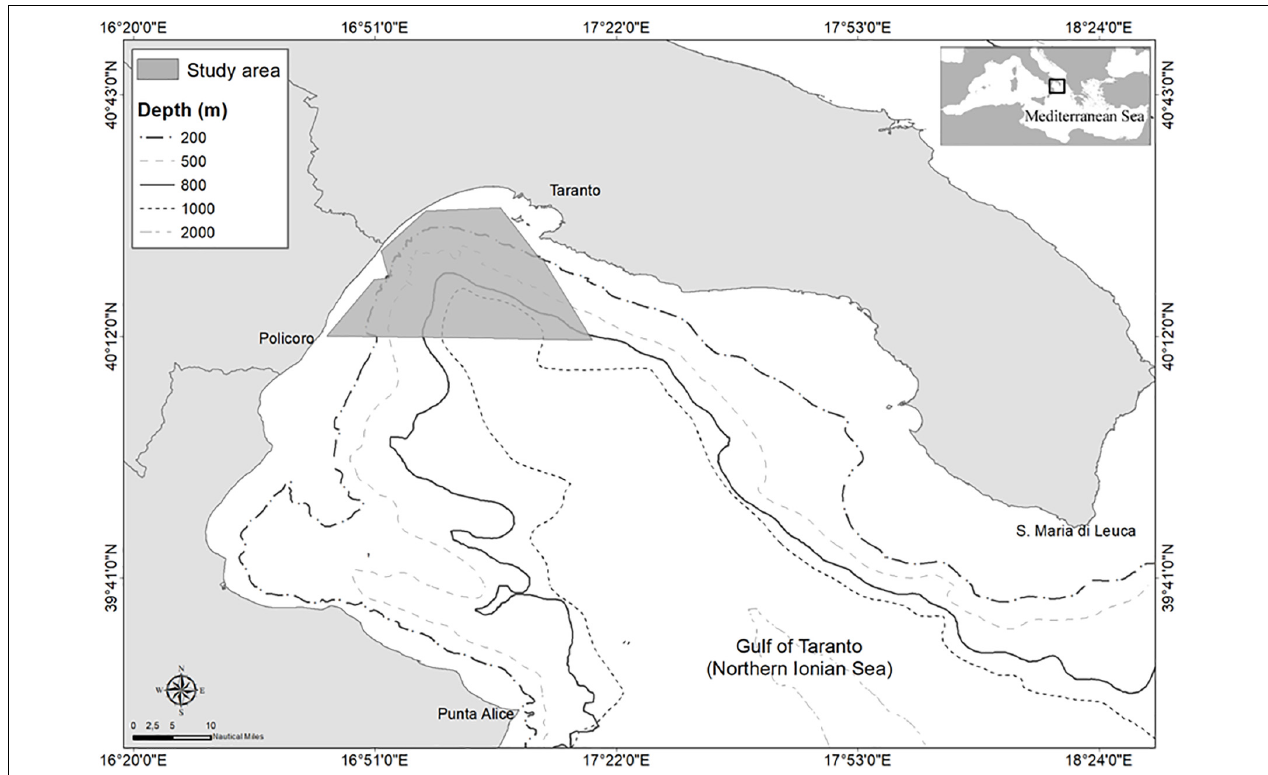
FIGURE 1 | Map of the study area. In the square, the survey area investigated in 2016–2017 in the Gulf of Taranto (Central-Eastern Mediterranean Sea).